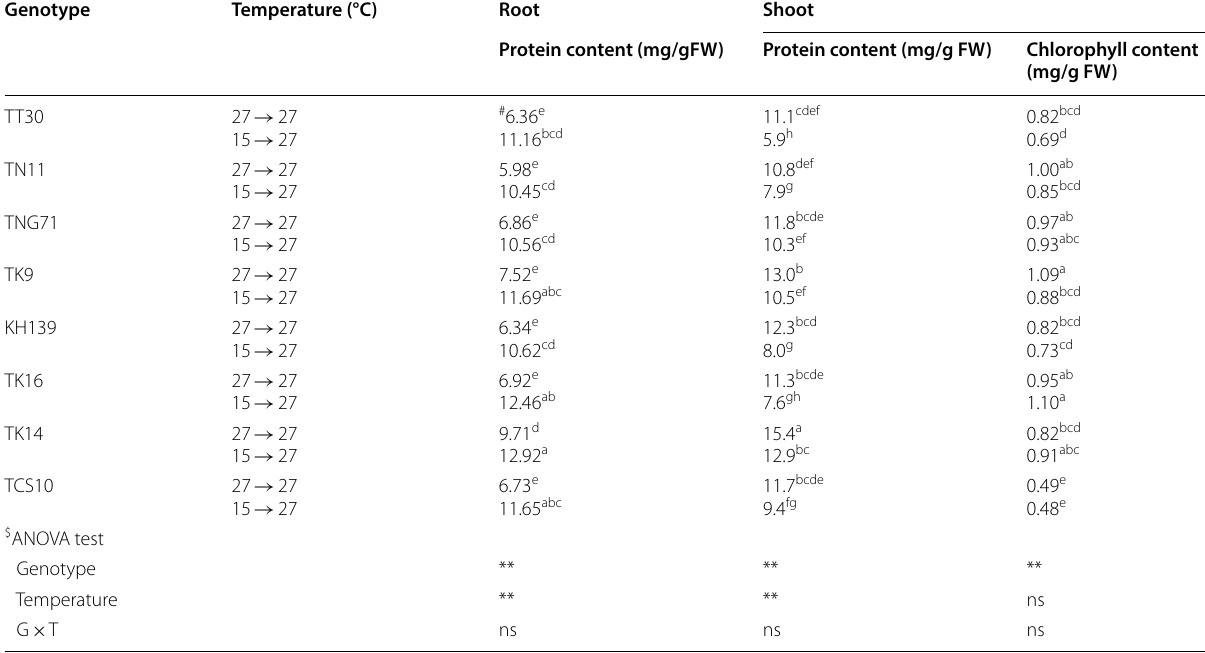
The temperature was set at 15 °C for cold treatment and 27 °C for control. After 4 days of treatment, the temperature was adjusted to 27 °C for 3 days before harvesting ns non-significant # Different letters represent the significant difference with LSD tests among cultivars or treatments (p < 0.05) $ G T: effect of genotype and temperature interaction; *p < 0.05; **p < ×